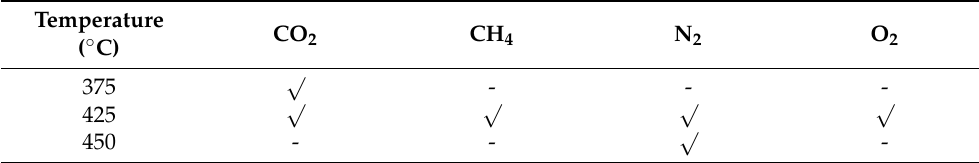
Figure 6. Compositions of hydrocarbons from pyrolysis of mixed metal basic soap at different reaction temperatures with Ca/(Ca + Mg + Zn) of 0.15 µ . Table 4. Gc-TCD analysis result of M-mix soap pyrolysis gas